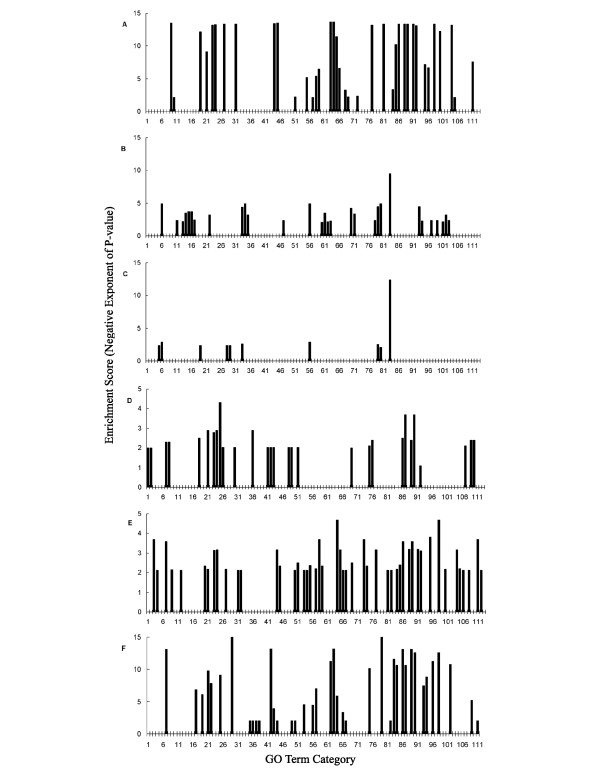
Analysis of Gene Ontology (GO) terms. Genes were categorized as significantly differentially expressed in a two-way comparison with false discovery rate correction and p < 0.05, and information about associated GO terms was extracted using Blast2GO [39]. Fisher's exact test was used to calculate the probability that the observed distribution of terms in the test set was significantly different (p-value < 0.05) from the distribution of all assembled sequences for the following comparisons: A) females vs. males; B) males vs. females; C) juvenile females vs. mature females; D) mature females vs. juvenile females; E) mature females vs. males; F) Daphnia and Drosophila conserved sex-biased genes. GO terms for each column are: 1, chromatin; 2, nucleosome; 3, nucleotide binding; 4, microtubule cytoskeleton organization and biogenesis; 5, lytic vacuole; 6, pattern binding; 7, nucleic acid binding; 8, DNA binding; 9, structural constituent of ribosome; 10, translation elongation factor activity; 11, catalytic activity; 12, GTPase activity; 13, endopeptidase activity; 14, serine-type endopeptidase activity; 15, chymotrypsin activity; 16, trypsin activity; 17, hydrolase activity, hydrolyzing O-glycosyl compounds; 18, chitinase activity; 19, structural molecule activity; 20, GTP binding; 21, cellular component; 22, extracellular region; 23, intracellular; 24, cell; 25, nucleus; 26, chromosome; 27, cytoplasm; 28, lysosome; 29, vacuole; 30, endoplasmic reticulum; 31, ribosome; 32, microtubule; 33, carbohydrate metabolism; 34, polysaccharide metabolism; 35, chitin metabolism; 36, nucleobase, nucleoside, nucleotide and nucleic acid metabolism; 37, DNA packaging; 38, establishment and/or maintenance of chromatin architecture; 39, chromatin assembly or disassembly; 40, nucleosome assembly; 41, transcription; 42, transcription, DNA-dependent; 43, regulation of transcription, DNA-dependent; 44, protein biosynthesis; 45, translational elongation; 46, protein complex assembly; 47, proteolysis and peptidolysis; 48, amino acid and derivative metabolism; 49, amino acid metabolism; 50, aromatic compound metabolism; 51, organelle organization and biogenesis; 52, chromosome organization and biogenesis (sensu Eukaryota); 53, cytoskeleton organization and biogenesis; 54, microtubule-based process; 55, physiological process; 56, chitin binding; 57, translation factor activity, nucleic acid binding; 58, biological_process; 59, metabolism; 60, peptidase activity; 61, serine-type peptidase activity; 62, catabolism; 63, macromolecule catabolism; 64, biosynthesis; 65, macromolecule biosynthesis; 66, cellular process; 67, microtubule cytoskeleton; 68, small ribosomal subunit; 69, cell organization and biogenesis; 70, hydrolase activity; 71, hydrolase activity, acting on glycosyl bonds; 72, isomerase activity; 73, purine nucleotide binding; 74, guanyl nucleotide binding; 75, regulation of nucleobase, nucleoside, nucleotide and nucleic acid metabolism; 76, regulation of metabolism; 77, protein metabolism; 78, protein catabolism; 79, carbohydrate binding; 80, polysaccharide binding; 81, ribonucleoprotein complex; 82, microtubule polymerization or depolymerization; 83, structural constituent of cuticle; 84, translation; 85, macromolecule metabolism; 86, organelle; 87, membrane-bound organelle; 88, non-membrane-bound organelle; 89, intracellular organelle; 90, intracellular membrane-bound organelle; 91, intracellular non-membrane-bound organelle; 92, protein complex; 93, biopolymer metabolism; 94, biopolymer catabolism; 95, cellular metabolism; 96, primary metabolism; 97, cellular catabolism; 98, cellular biosynthesis; 99, cellular protein catabolism; 100, cellular macromolecule metabolism; 101, cellular carbohydrate metabolism; 102, cellular polysaccharide metabolism; 103, cellular macromolecule catabolism; 104, cellular protein metabolism; 105, translation regulator activity; 106, tubulin; 107, regulation of transcription; 108, microtubule polymerization; 109, regulation of biological process; 110, regulation of physiological process; 111, cellular physiological process; 112, protein polymerization; 113, chromosome organization and biogenesis.